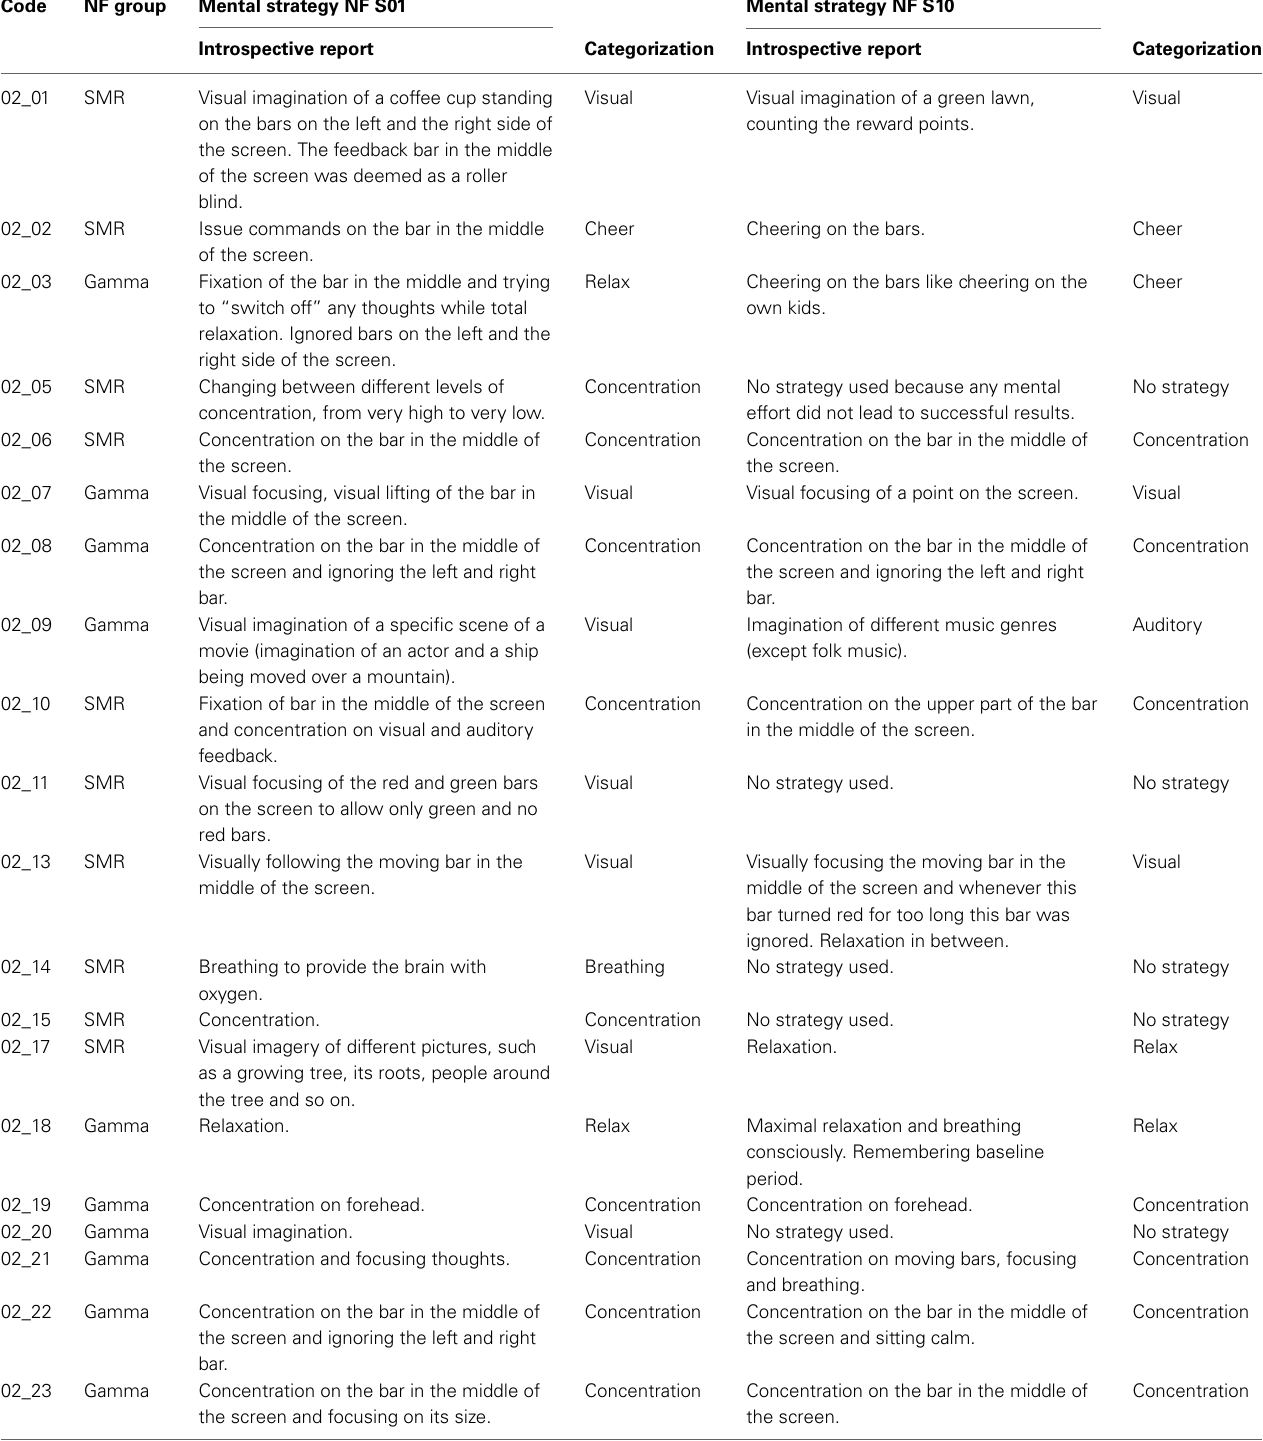
Table A1 | Introspective reports of the used mental strategies to gain control over the feedback bars during the first (NF S01) and last (NF S10) neurofeedback training session, presented separately for each participant and the subsequent classification into the different strategy categories (visual strategies, auditory strategies, cheering strategies, relaxation, concentration, breathing, and no strategy).